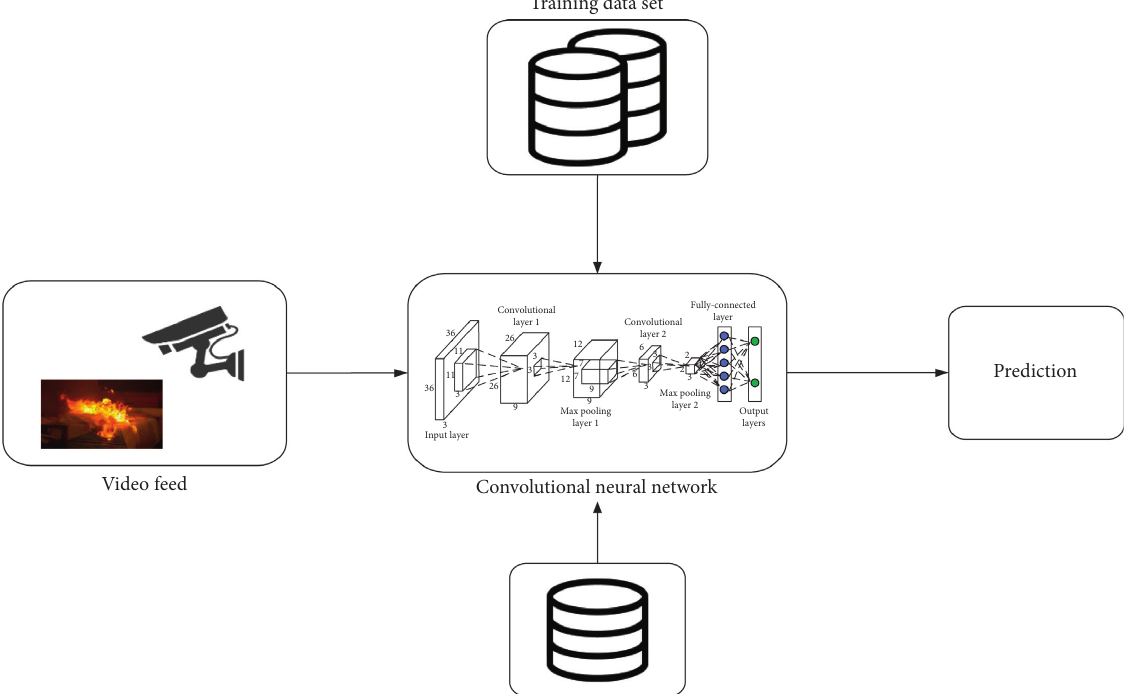
Figure 12: Video processing unit on a dedicated server.